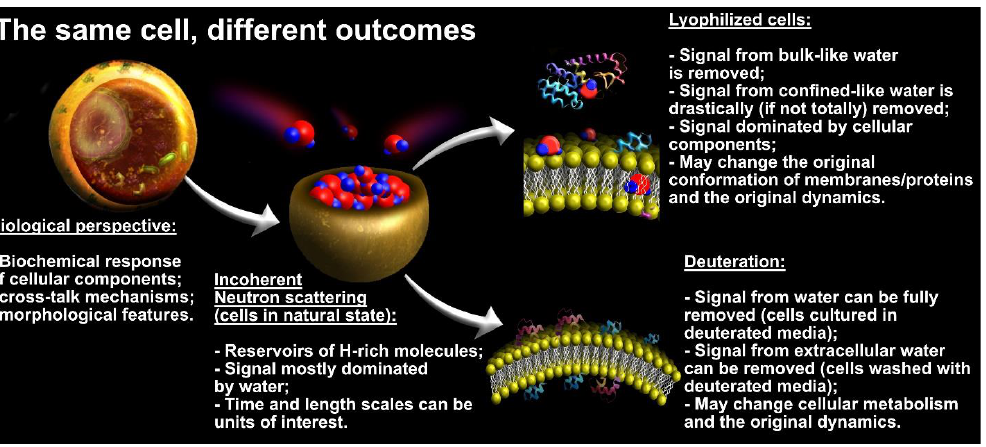
Figure 5. Schematics of the different outcomes obtained in QENS experiments with cancer cells.